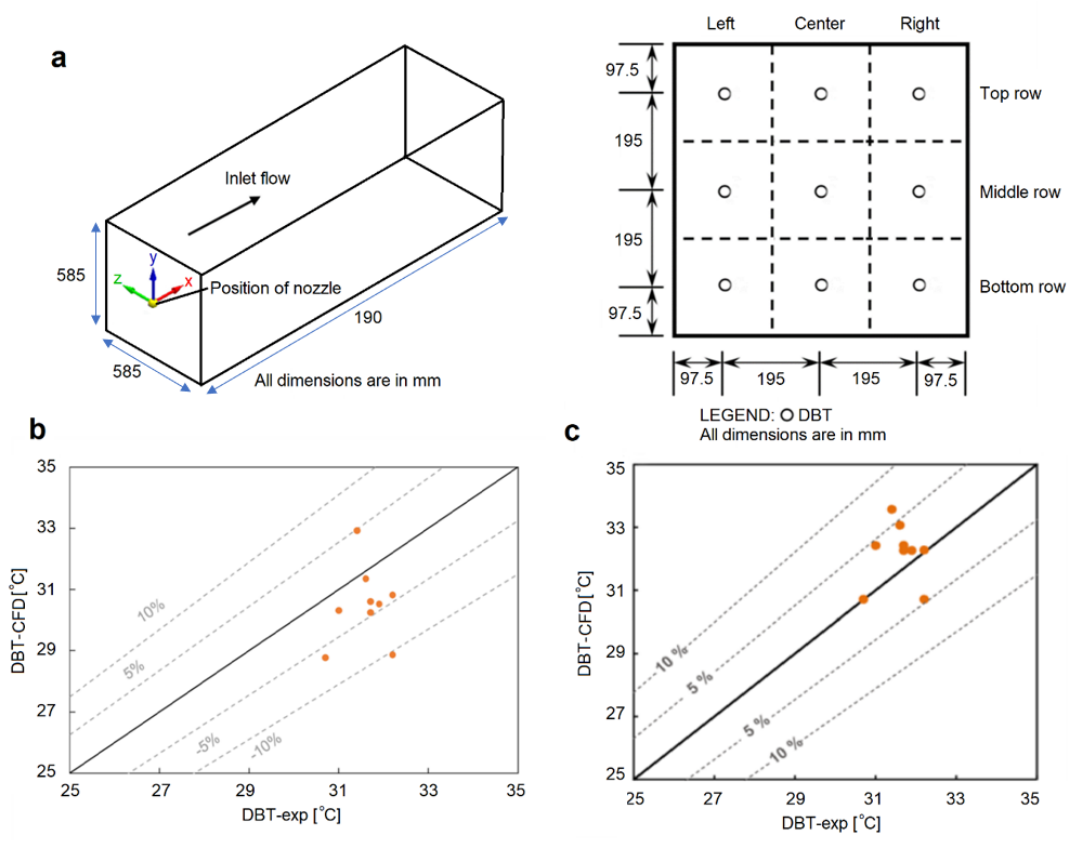
Figure 9. ( a ) Dry-bulb temperature measurement locations on the outlet plane [24]; ( b ) Comparison between experimental measurements [24] and current CFD results for dry bulb temperatures (DBTs); ( c ) Comparison between experimental measurements [24] and previous CFD results [23] for dry bulb temperatures (DBTs).